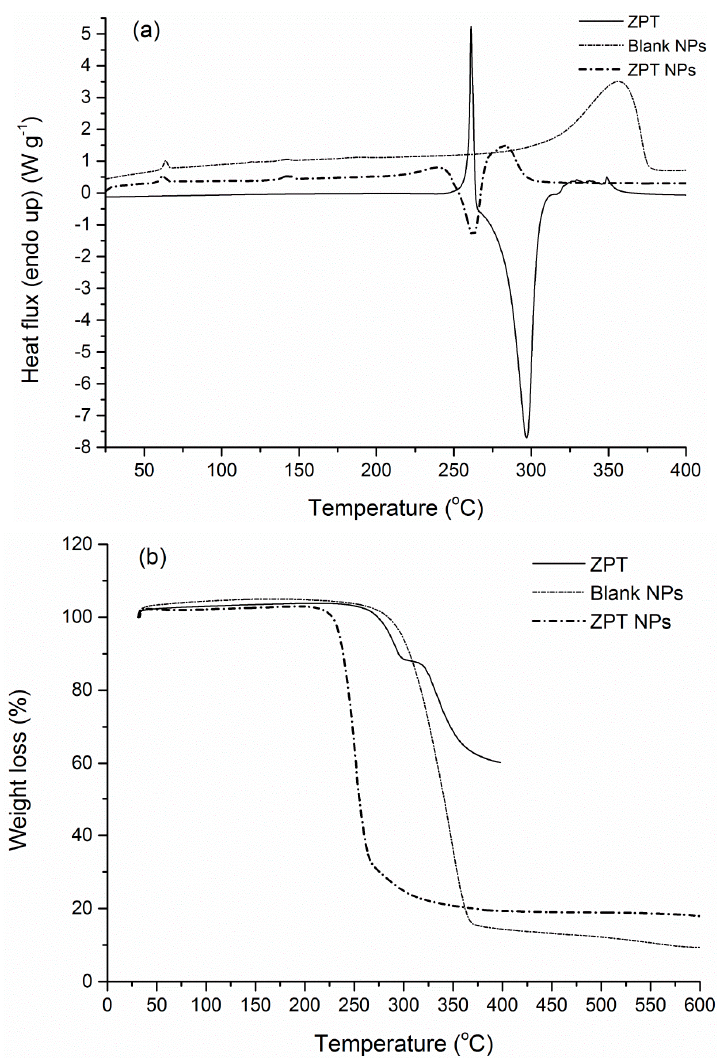
Figure 10. ( a ) DSC and ( b ) TGA curve of ZPT NPs and comparison curves.